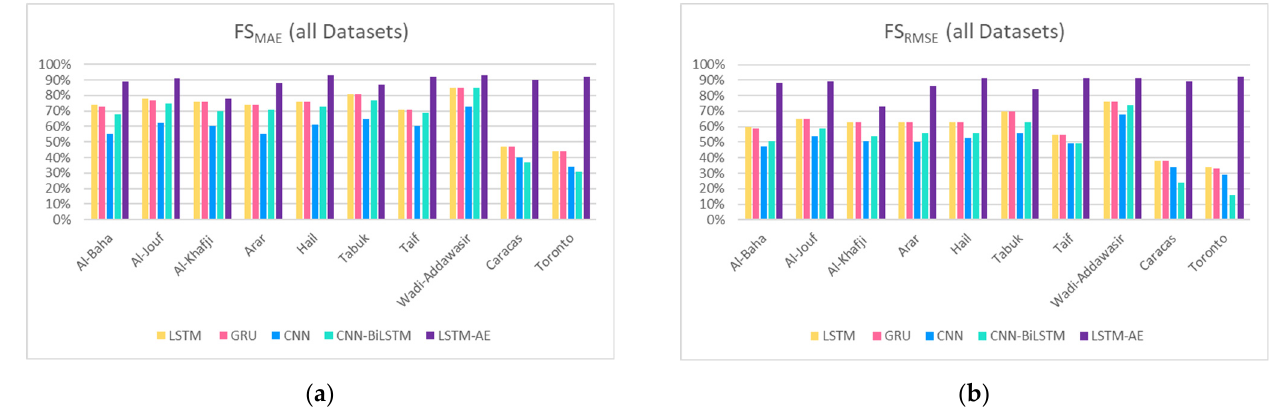
Figure 26. Forecasting results of 5 models for all datasets ( a ) FS MAE ; ( b ) FS RMSE .